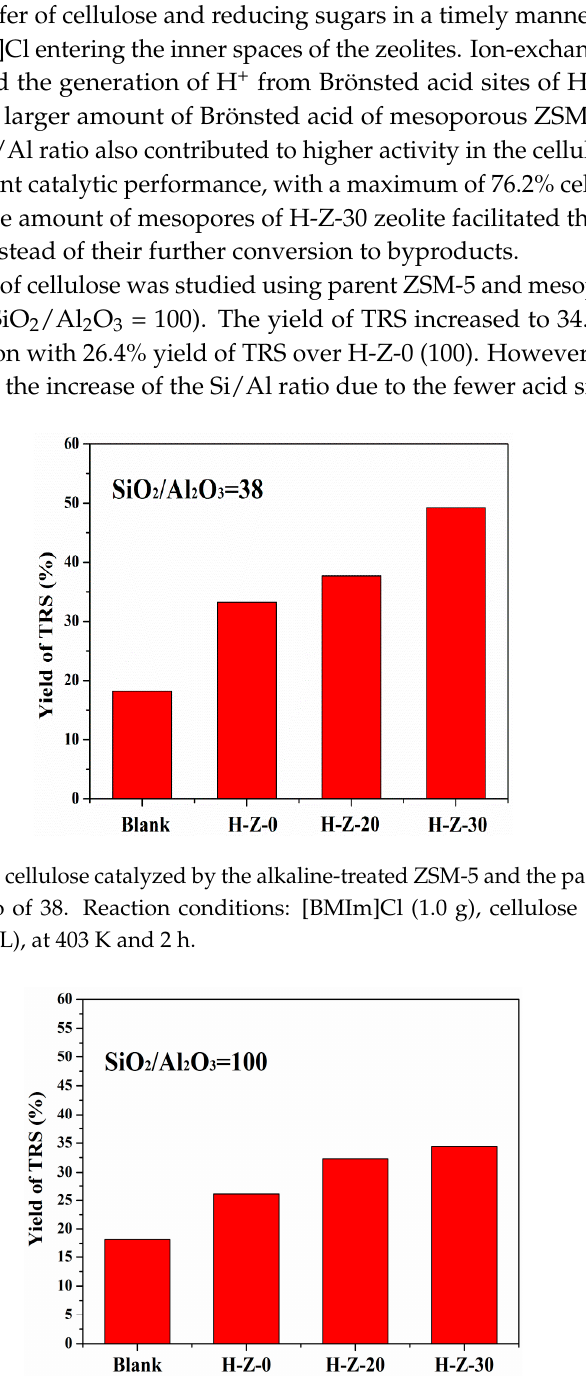
Figure 4. Hydrolysis of cellulose catalyzed by the alkaline-treated ZSM-5 and the parent ZSM-5 zeolites with SiO 2 /Al 2 O 3 ratio of 100. Reaction conditions: [BMIm]Cl (1.0 g), cellulose (50.0 mg), catalyst (50.0 mg), water (0.2 mL), at 403 K and 2 h.